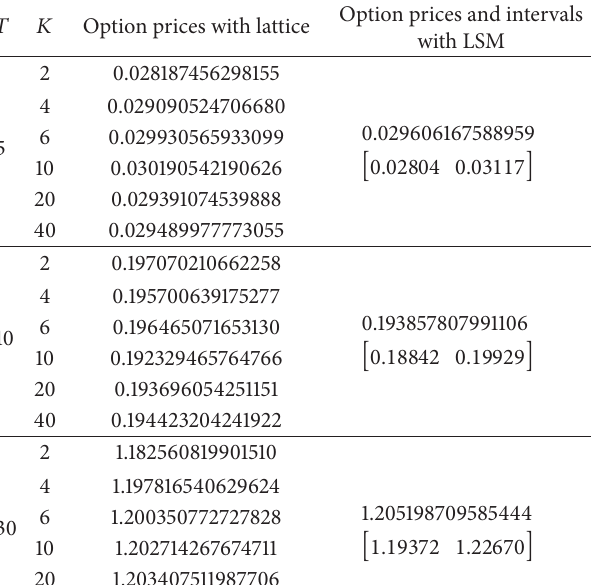
Table 5: Numerical results for Example